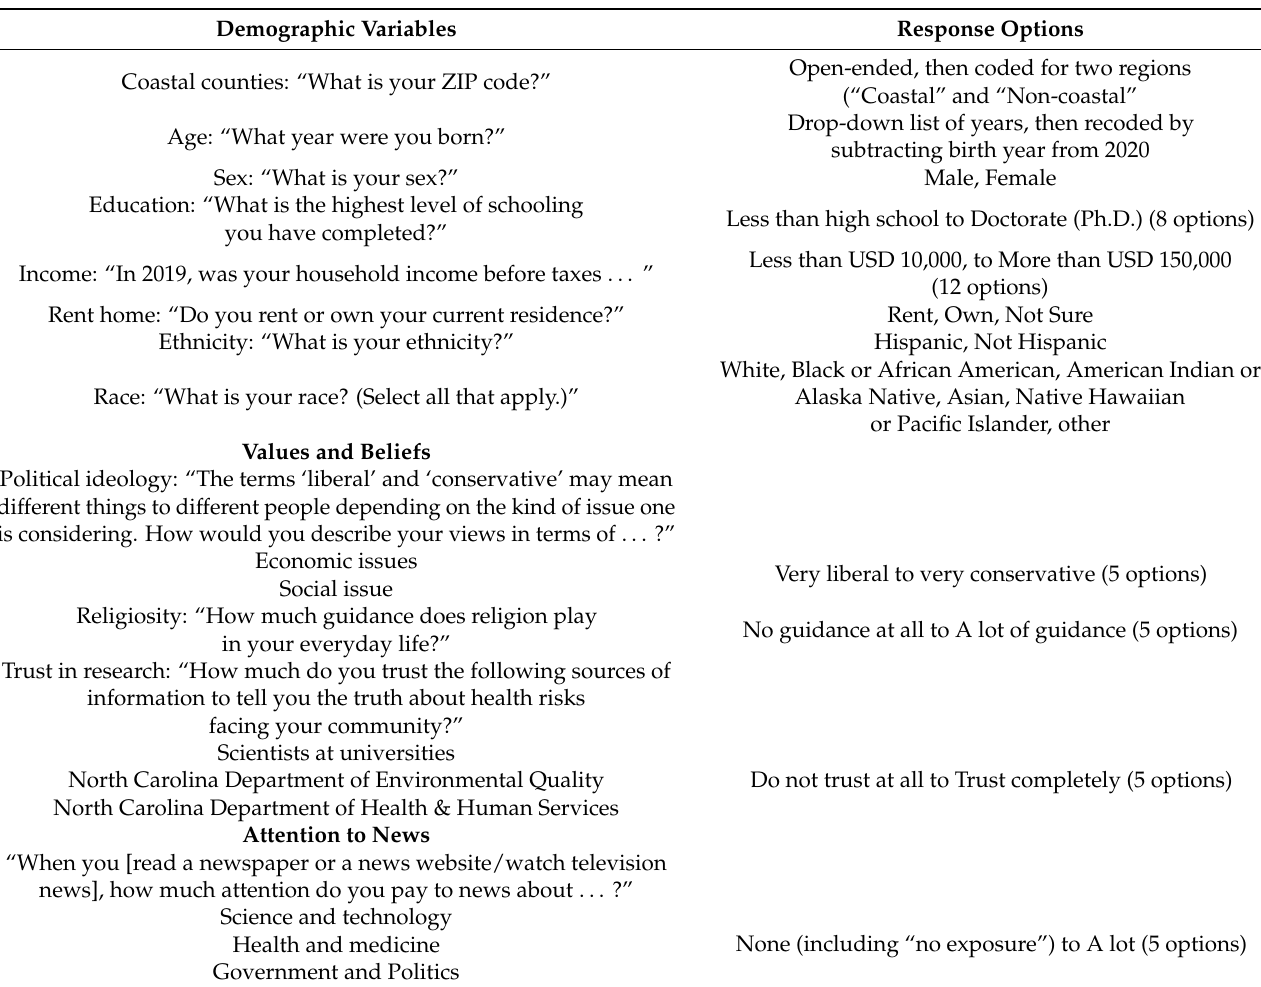
Table A2. Survey item wording for all other independent variables.